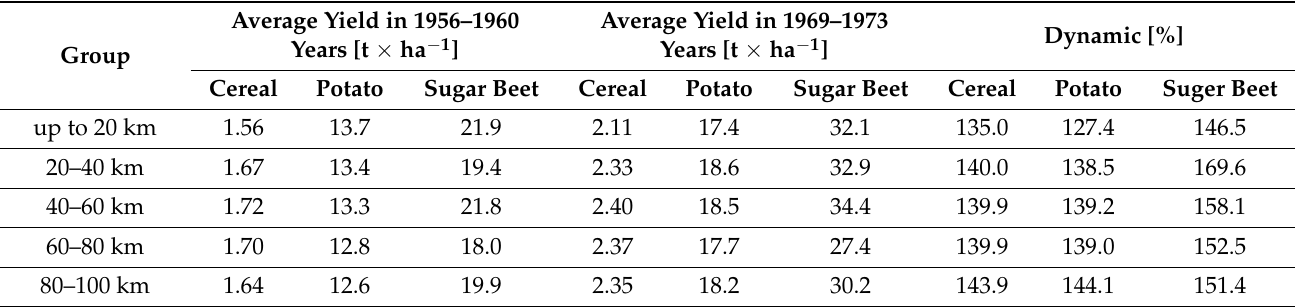
Table 2. The yield of selected crops and the dynamics of yield depending on the distance from the open-pit mines (according to the data from the analyzed